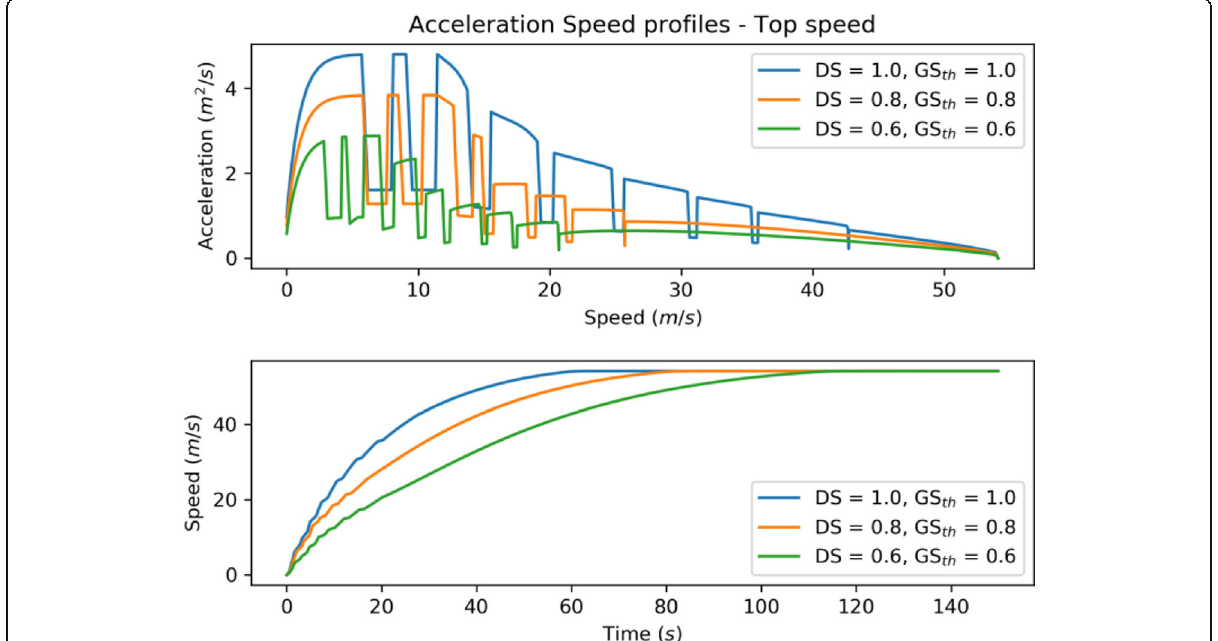
Fig. 1 Simulation of free-flow acceleration from 0 km/h to maximum speed for a commercial vehicle with a 9-speed automatic gearbox. Top: Acceleration-Speed profiles for three different drivers with different driving styles. Bottom: The simulated speed profiles for the same drivers